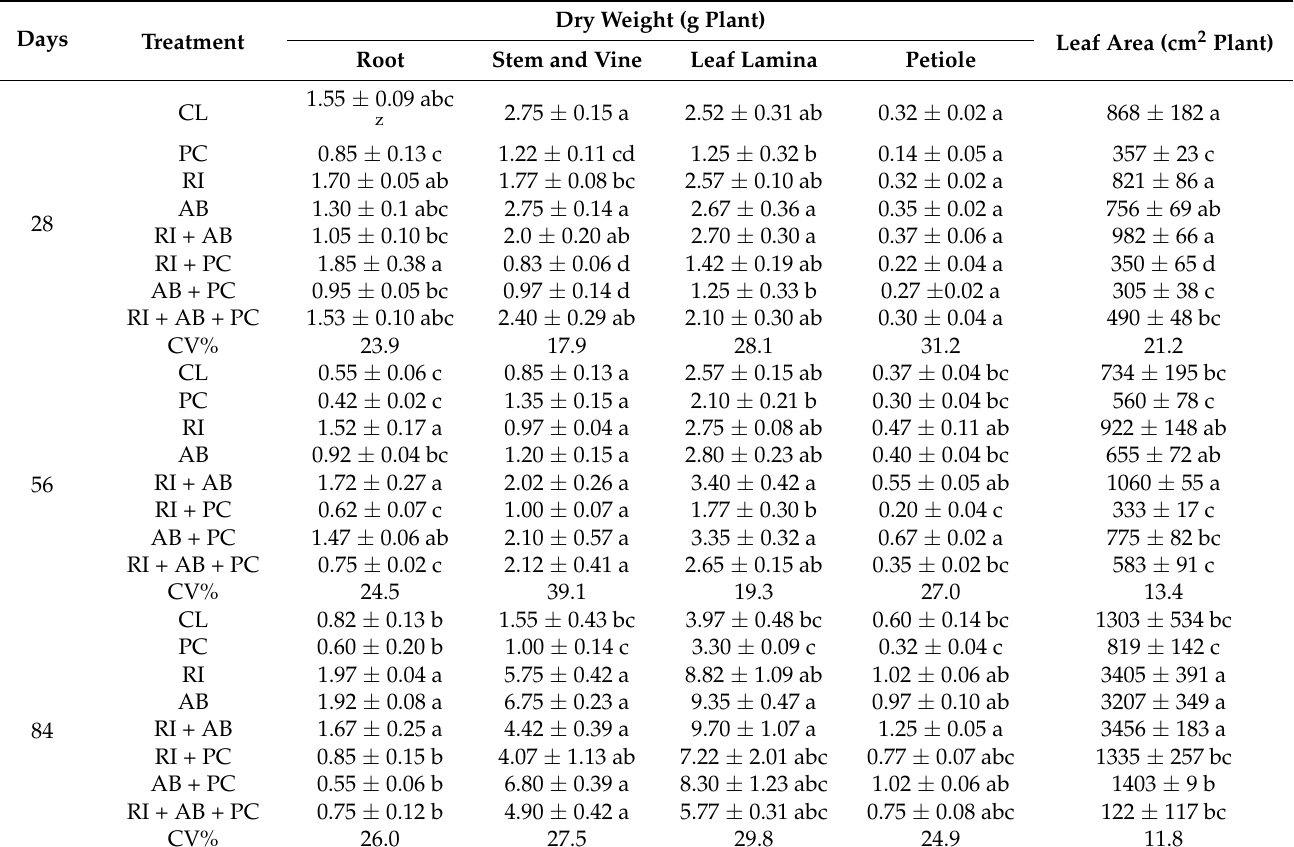
Table 2. Comparisons of means of dry weight of root, stem, leaf blade, petiole, and leaf area of S. edule var. virens levis Costa Rica Type, biofertilized with A. brasilense and R. intraradices and inoculated with P. capsici in an andosol-molic soil from Soconusco,